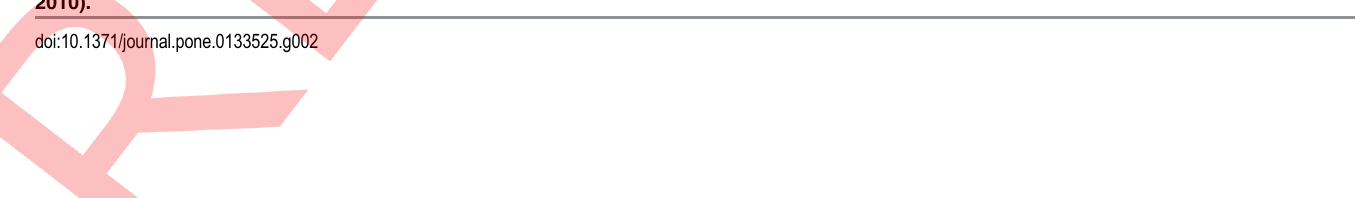
PLOS ONE | DOI:10.1371/journal.pone.0133525 August 19,